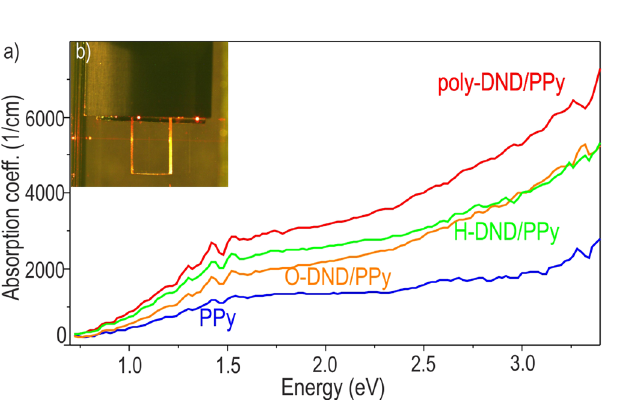
Figure 4. AFM maps with indicated locations of SNOM-IR spectra of ( a ) PPy reference ( b ) O-DND/PPy ( c ) poly-DND/PPy. The lateral size of the particles’ and PPy agglomerates could be deduced from the scale bars on AFM images. Characteristic PPy peaks at 1671 (N–H vibration) and 1408 (C–N vibration) cm −1 are indicated at SNOM-IR spectra.